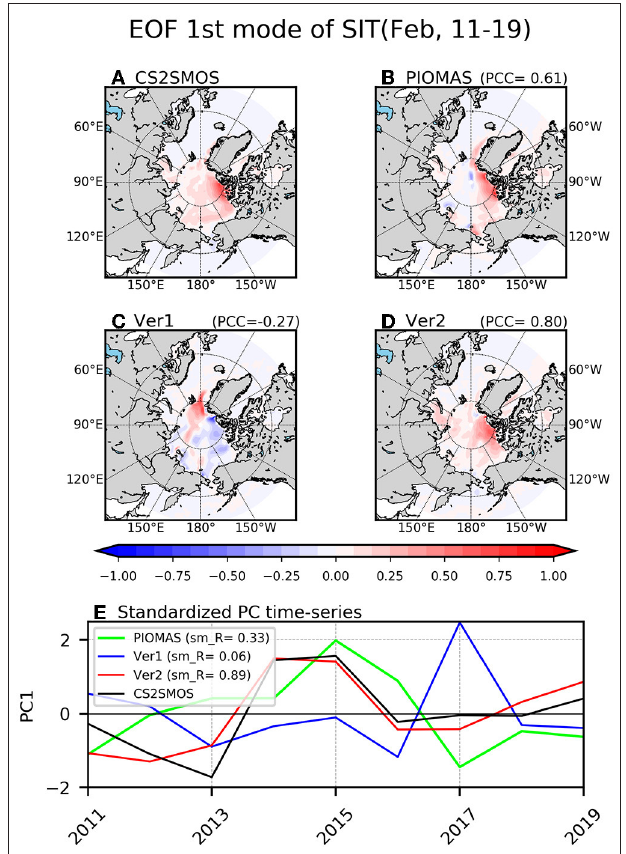
FIGURE 13 | The spatial distributions of the eigenvector of the first empirical orthogonal function mode of sea ice concentration (a fraction from 0 to 1) for SSMIS NT observation (A) , PIOMAS reanalysis (B) , Ver1 (C) , and Ver2 (D) in February during the period 2000–2019. The pattern correlation represented “PCC” is calculated between SSMIS NT observation and each product. The time-series of the principal component (E) for SSMIS NT (black), PIOMAS (light green), Ver1 (blue), and Ver2 (red) is calculated and the “sm_R” represents the correlation coefficients with SSMIS NT data.